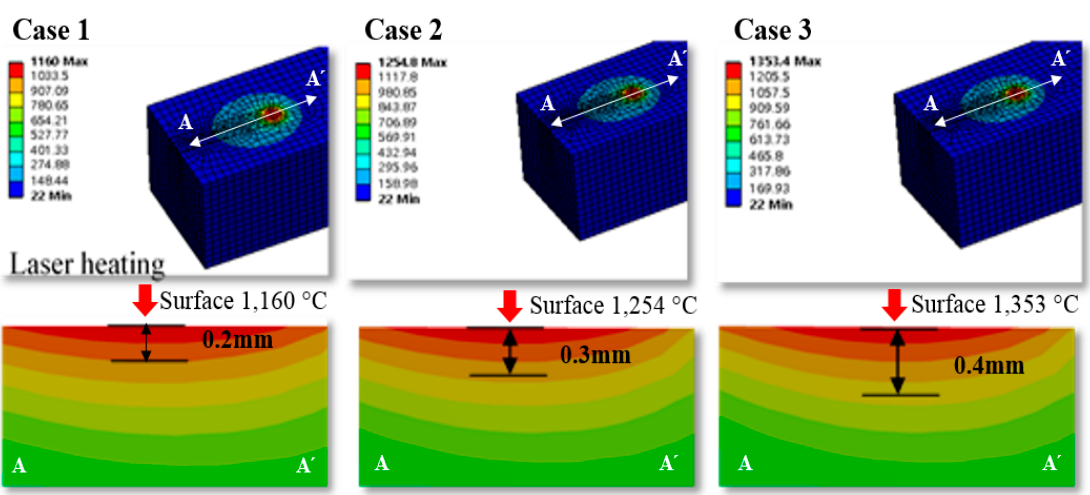
Figure 4. The finite element analysis result and the effective depth of the cut according to the preheating preheating temperature.